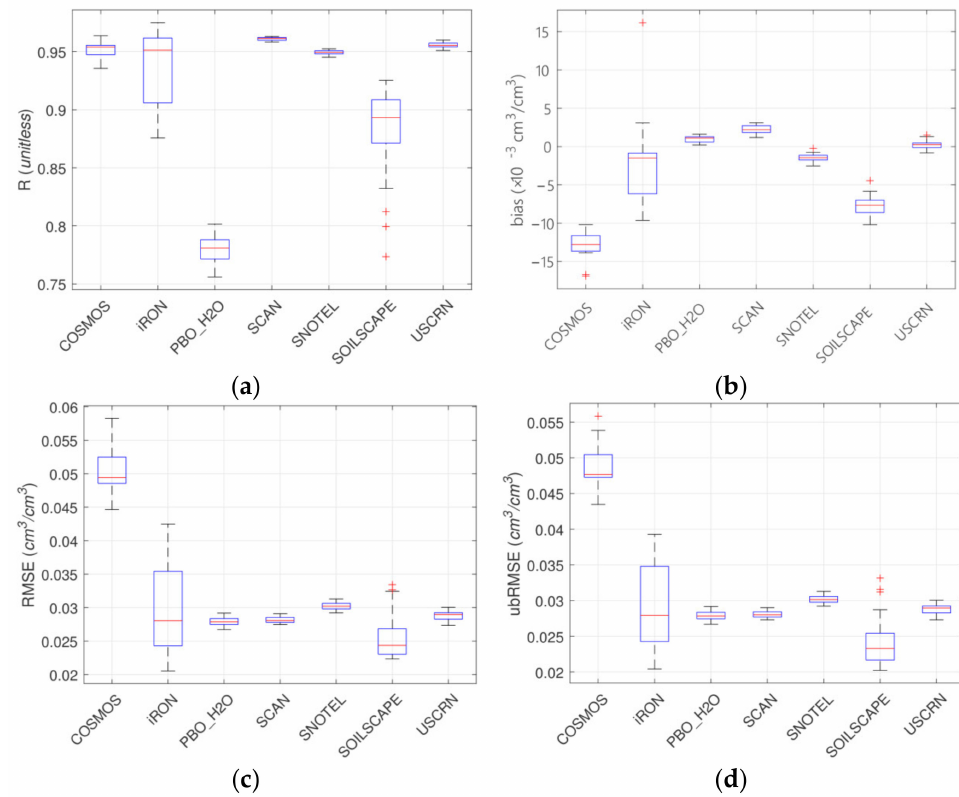
Figure 15. Box plots for ( a ) R, ( b ) bias, ( c ) RMSE, and ( d ) ubRMSE of each network.